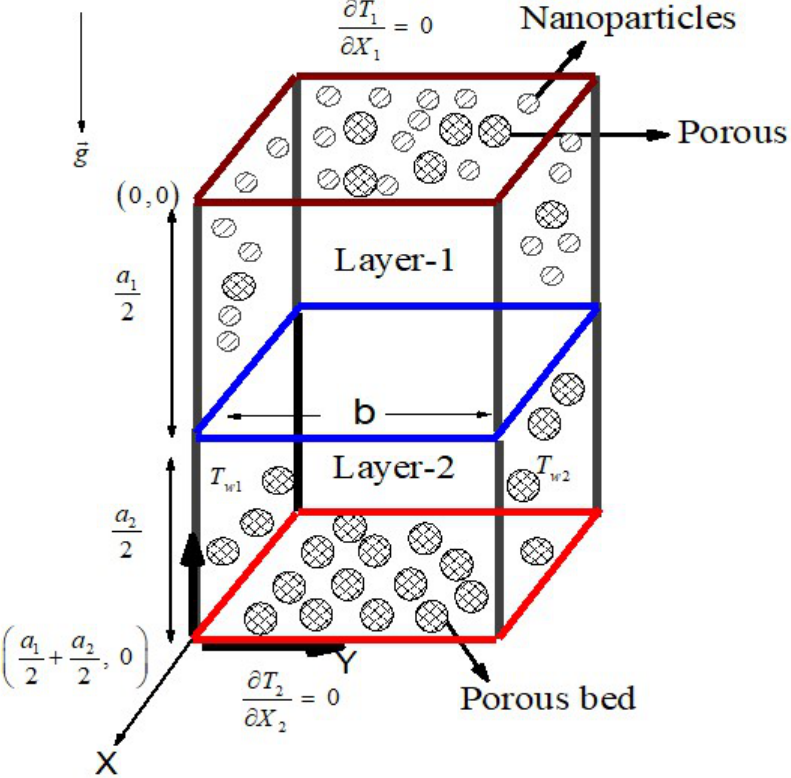
Figure 1. Physical